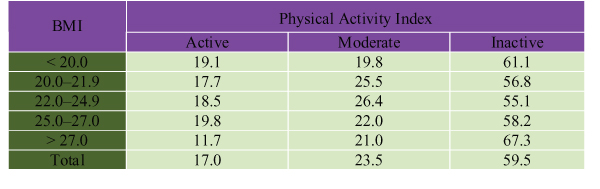
Percentage of Canadian Women in Each Physical Activity Category for Each BMI Group Source: Statistics Canada, NPHS, 1996–1997